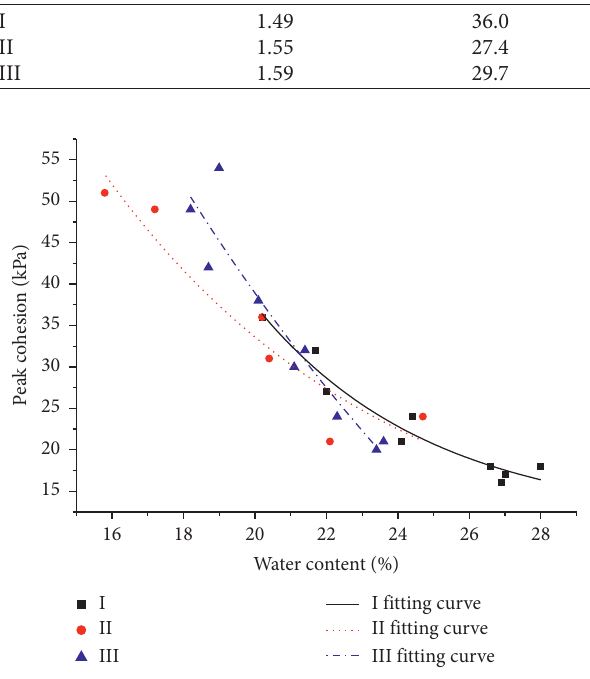
Figure 12: The curve of peak cohesive strength with moisture content change.